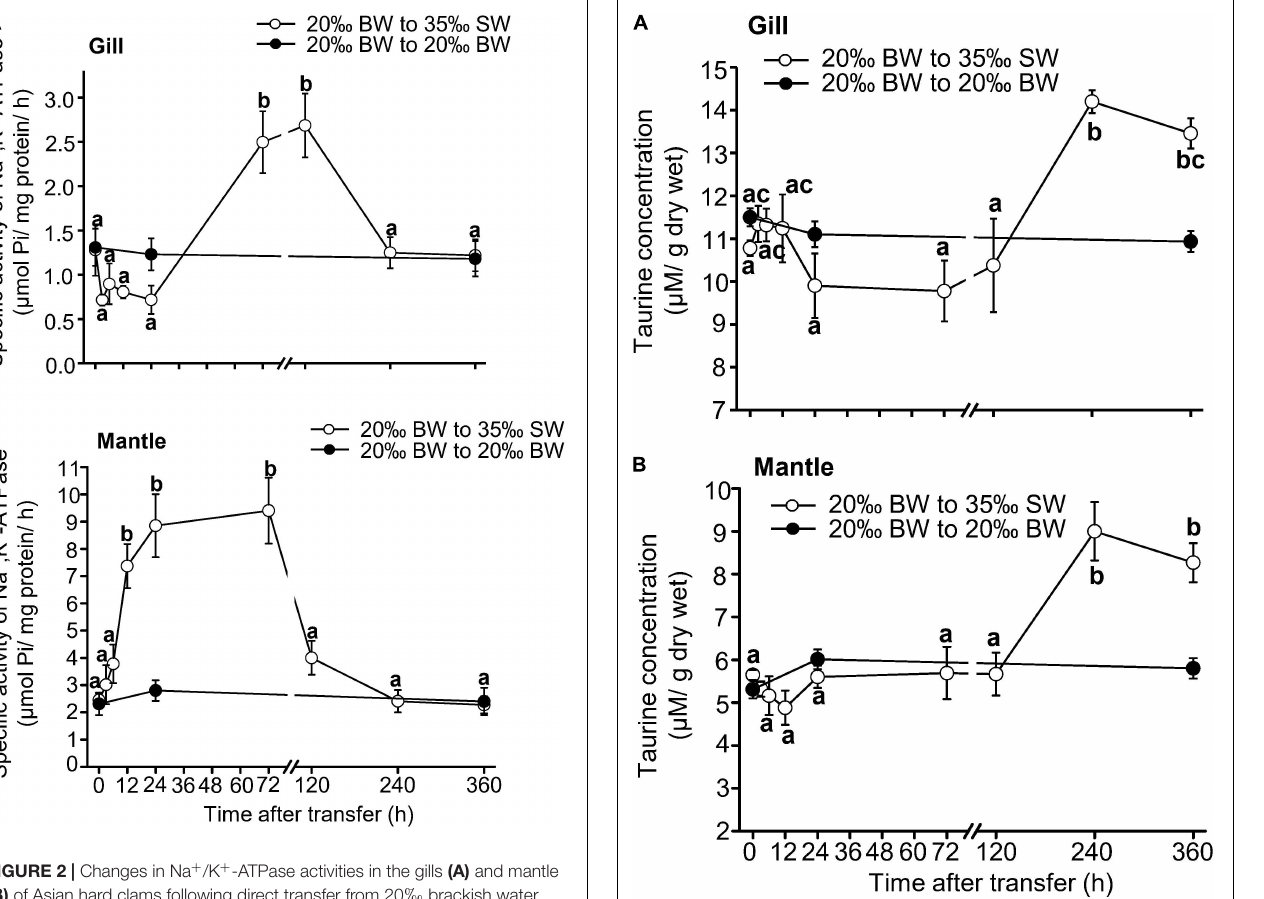
brackish water (cid:104) FIGURE 3 | Changes in taurine content in the gills (A) and mantle (B) of Asian hard clams transferred directly from 20 BW). Values are the different time points, by the Tukey’s pairwise test following the one-way (cid:104) analysis of variance (ANOVA) ( p < 0.05). No significant difference was found among time-points in the control group (from 20 to 20 means ± SEM ( N =